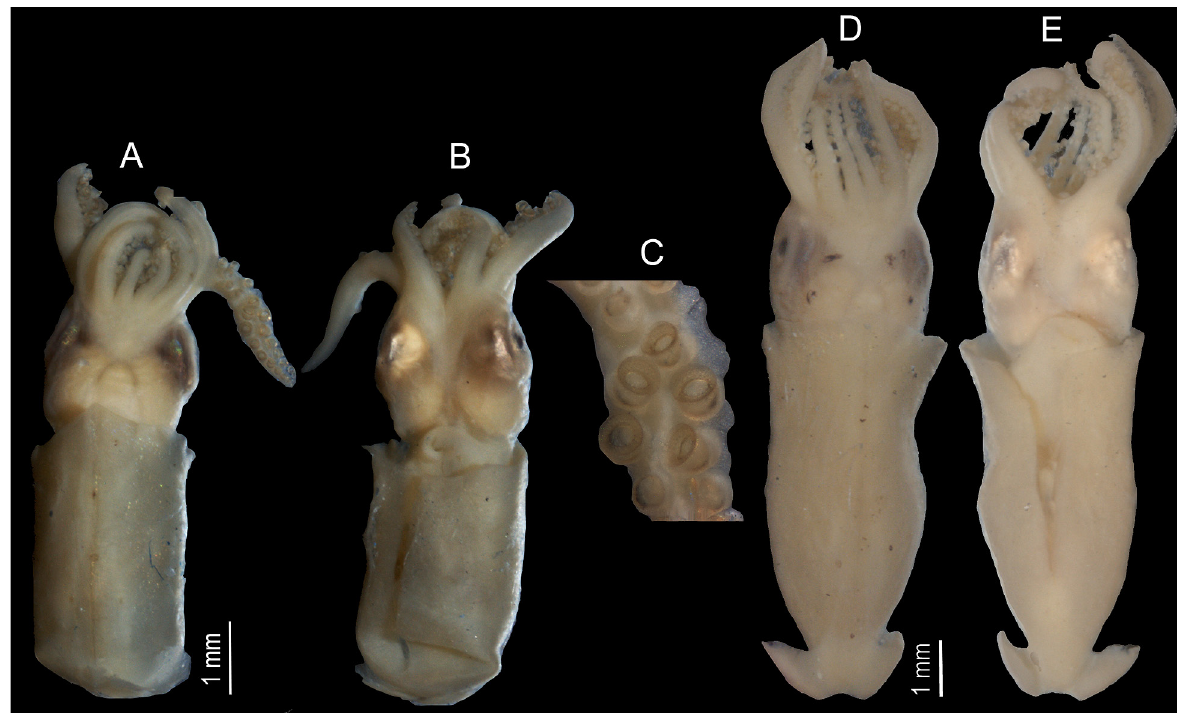
Figure 2. Pickfordiateuthis vossi . Dorsal ( A ) and ventral ( B ) view of 4.0 mm ML paralarvae and detail of tentacular club ( C ) with 2 rows of suckers. Dorsal ( D ) ad ventral ( E ) view of 6.8 ML